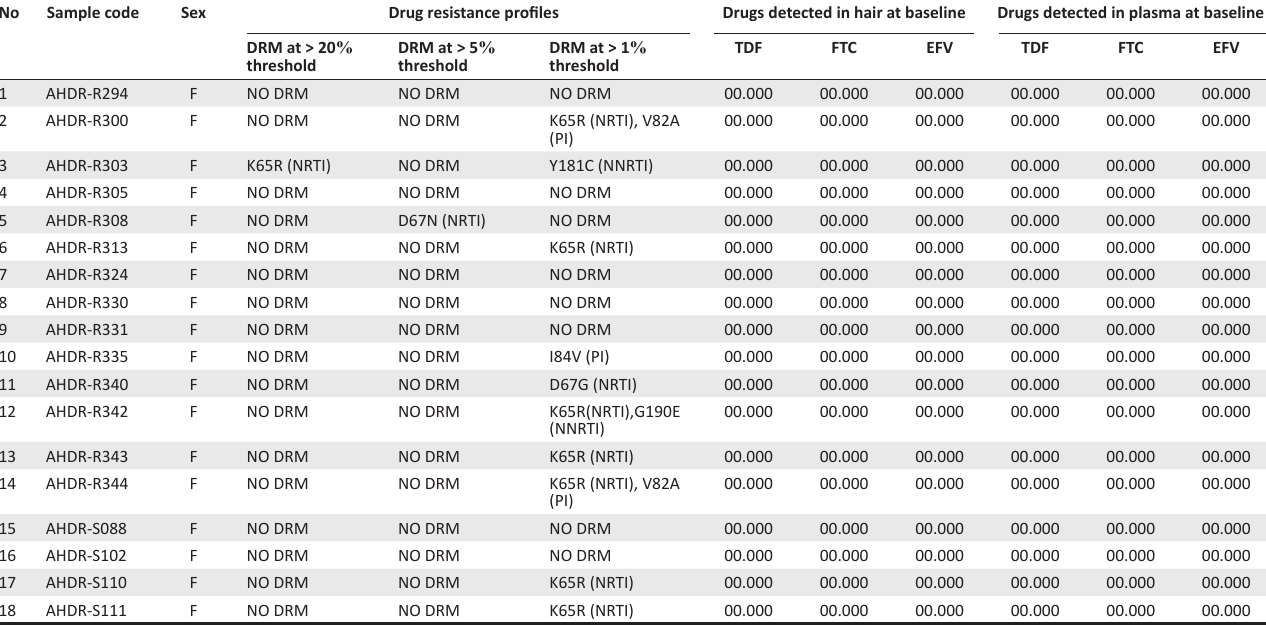
TABLE 4: Participants with no drug at baseline in either the hair or plasma matrix with their drug resistance profiles. No Sample code